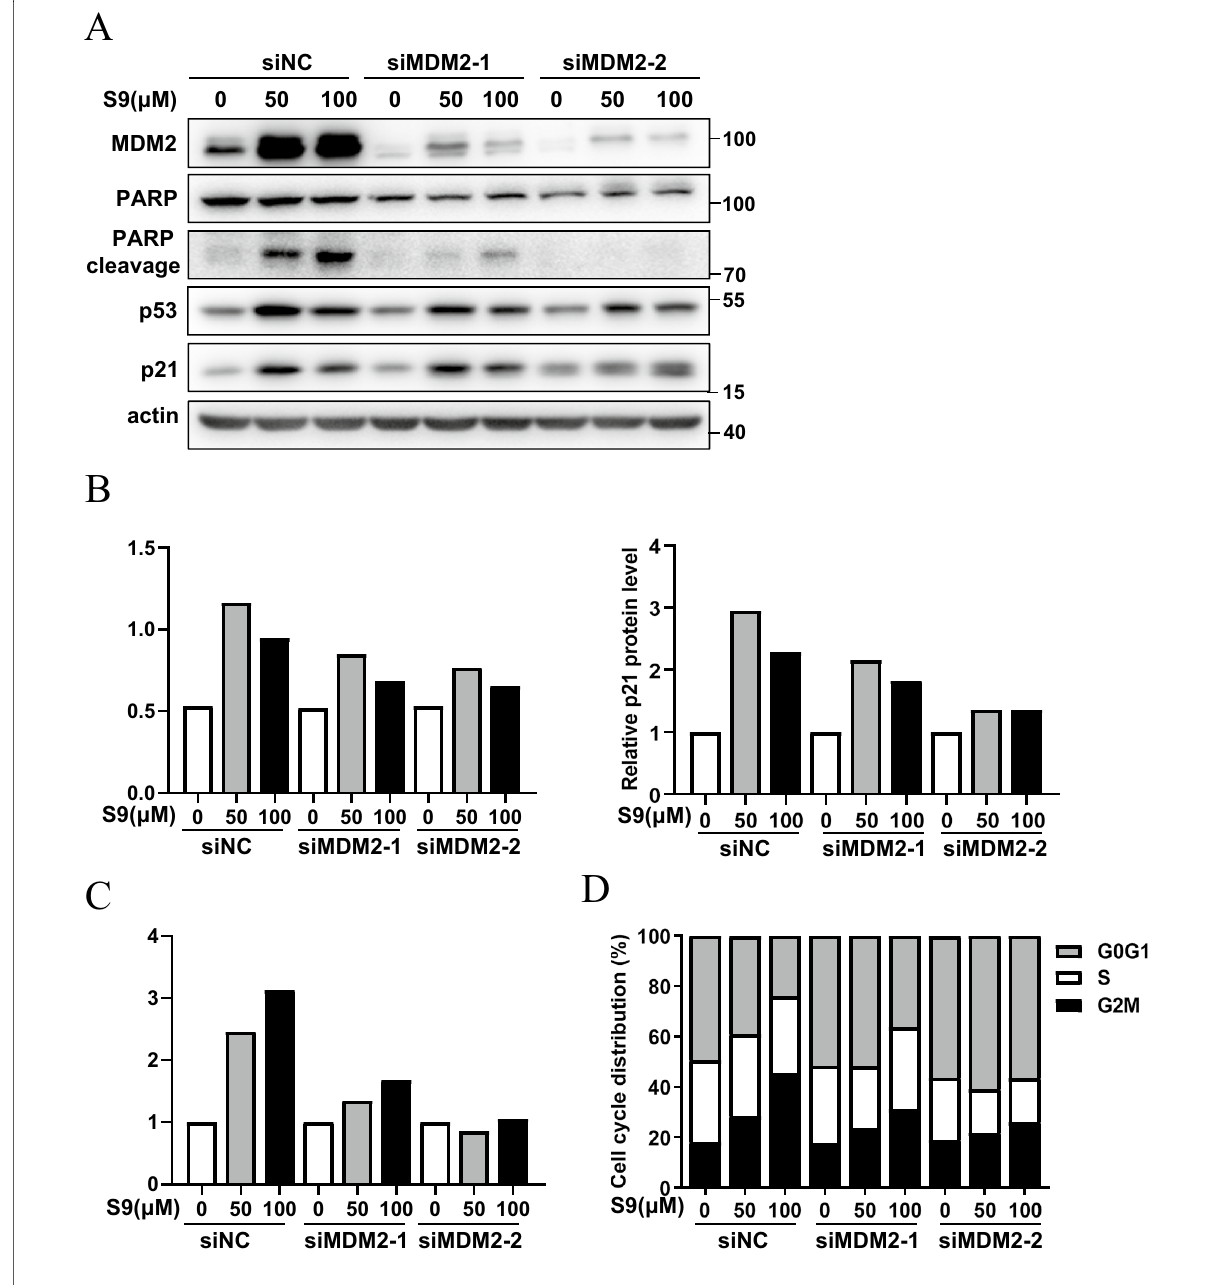
Fig. 5 MDM2 is required for S9-induced p53 activation, apoptosis and cell cycle arrest. A U2OS cells were transfected with MDM2 siRNA followed with described concentration of S9 treatment for 24 h, MDM2, PARP cleavage and p53 protein levels were detected by western blot analysis. B The quantitation results of p53 and p21 western blotting images. C The quantitation results of cleaved PARP(CL)/total PARP(TL) western blotting images. D U2OS cells were transfected with MDM2 siRNA followed with described concentration of S9 treatment for 24 h, stained with PI and analyzed by flow